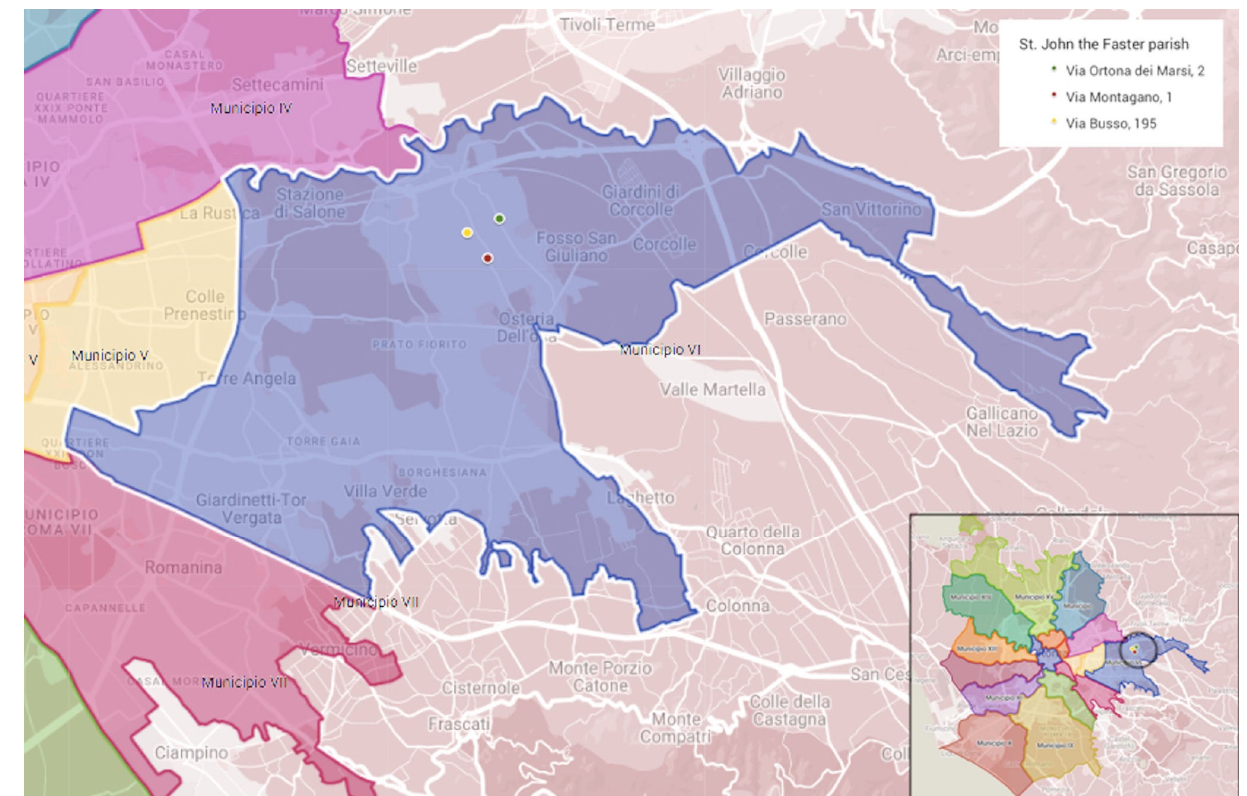
Figure 3. Displacement of the parish seat. Source: Elaboration on Google Maps by SO.